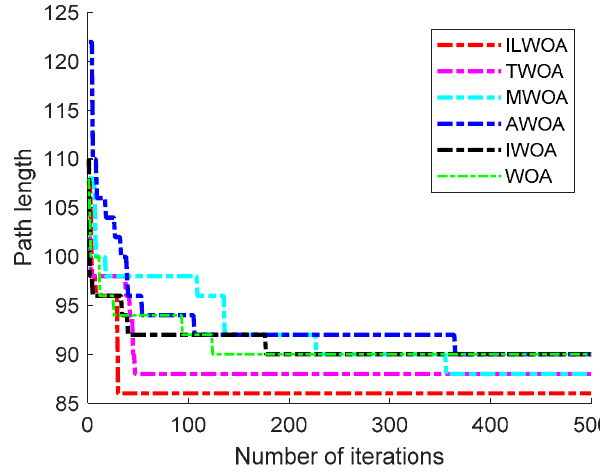
Figure 14. Optimal iteration curve.